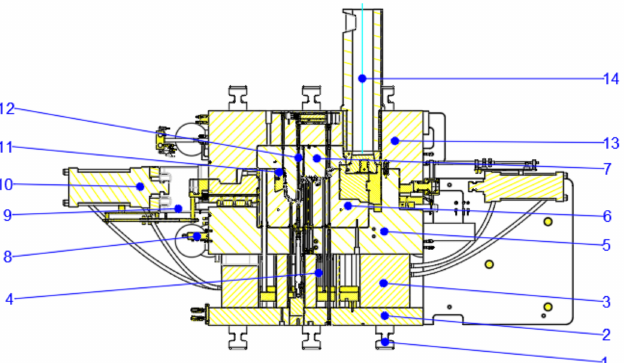
Figure 7. Die Casting Die Diagram: 1—Mold locking column; 2—Base plate; 3—Fixed block; 4— Thimble; 5—Moving mold frame; 6—Moving die core; 7—Fixed die core; 8—Water collector; 9— Cylinder bracket; 10—Oil cylinder; 11—Moving insert; 12—Cooling water pipe; 13—fixed mold frame; 14—melting